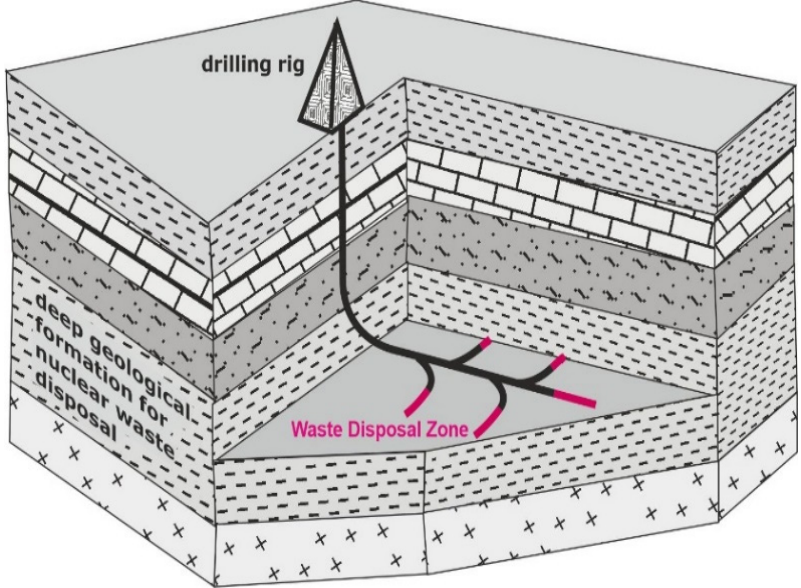
Figure 9. Scheme of disused sealed radioactive sources (DSRS), high-level radioactive waste (HLW), and spent nuclear fuel (SNF) disposal in branching lateral drillholes within suitable geological horizons. Reprinted from with permission of Elsevier from [36].